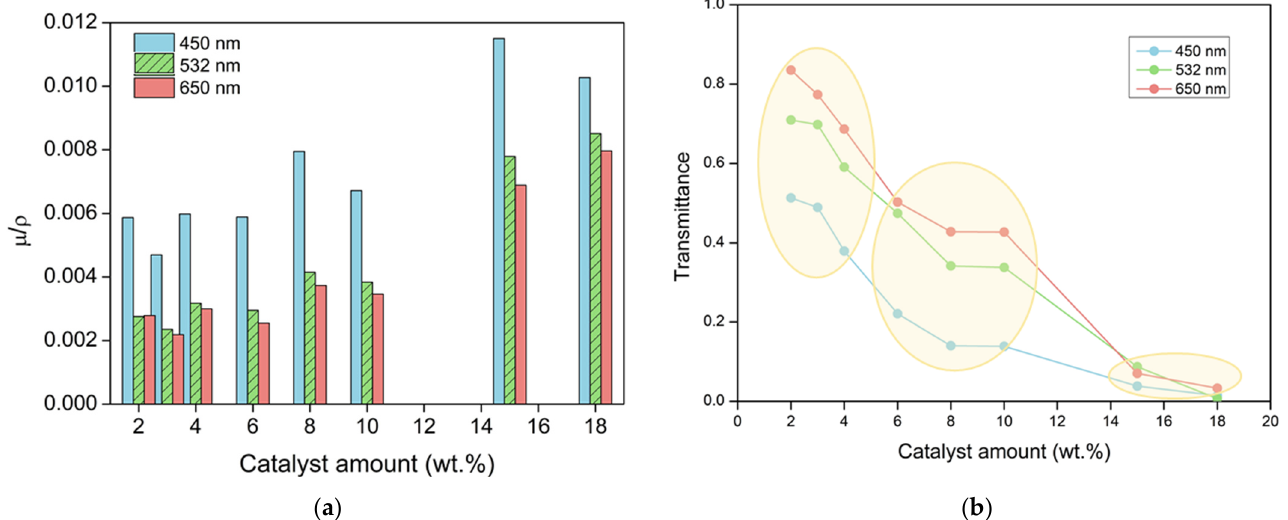
Figure 5. ( a ) Normalized attenuation coefficient for the aerogels containing each of the catalyst amounts and selected wavelengths. ( b ) Transmittance dependence with the catalyst amount for three different laser wavelengths for samples of 1 mm thickness. Numerical values can be found in Table S3 of the Supporting Information.